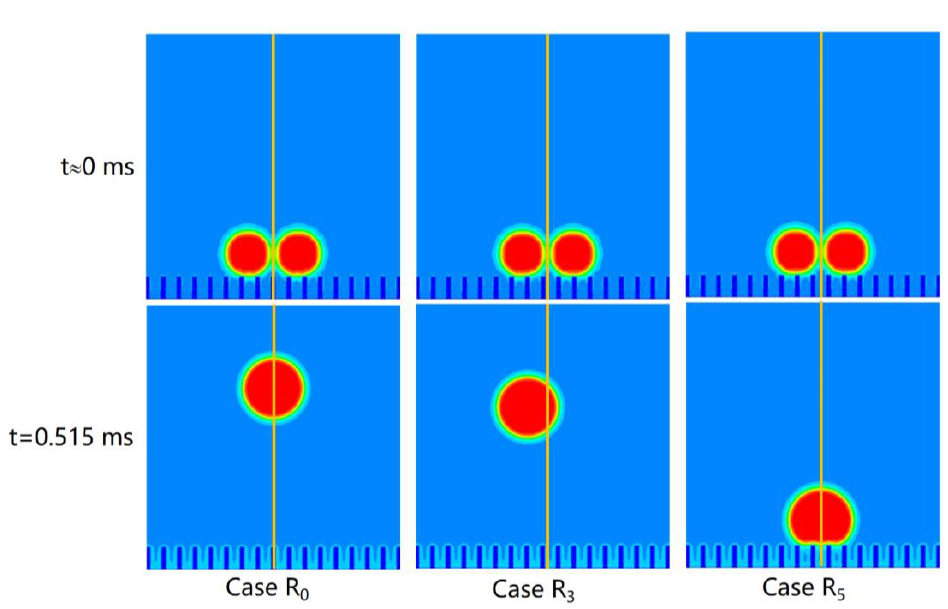
Figure 3. Schematic diagram of the periodic textured surface with flat-topped pillars (structure height h = 15 lattice, gap a = 7 lattice, pillar width w = 3 lattice). The initial position of the droplet pair is indicated by the mutual tangent of two droplets (red dotted line). The mutual tangent line is initialized from position (i) to (ii) in different cases.